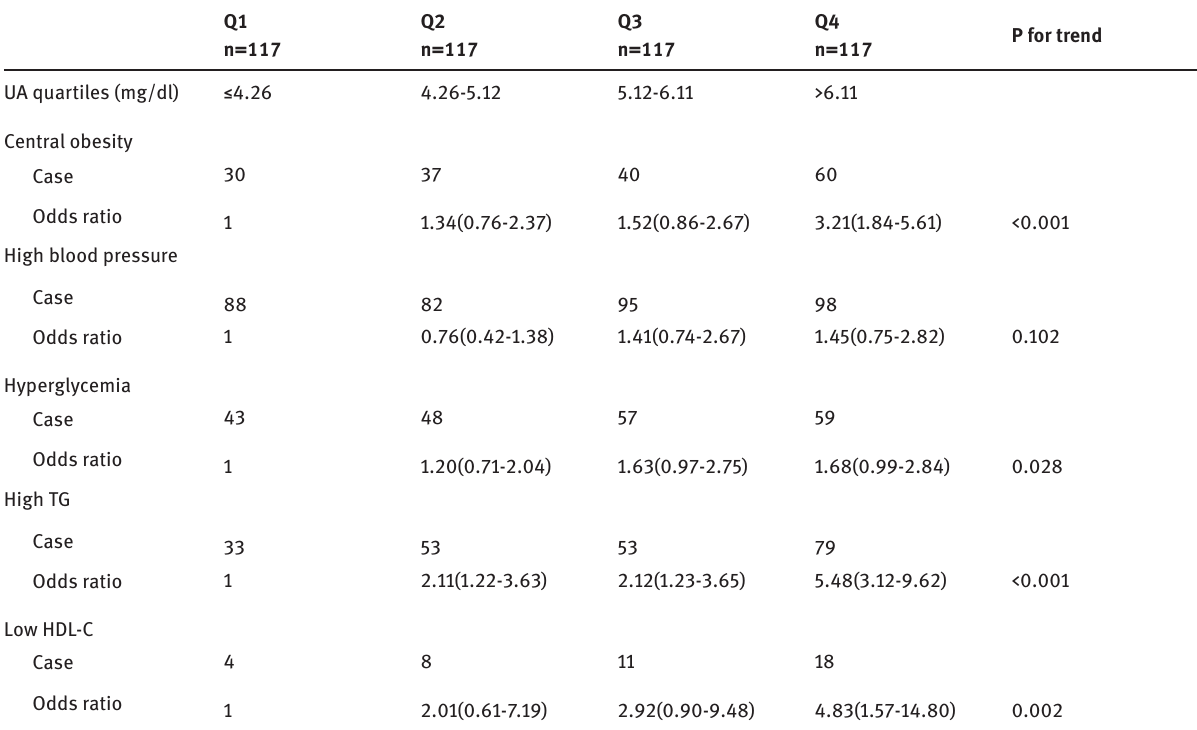
Table 4: Age-adjusted odds ratios of each individual MetS components according to quartiles of UA